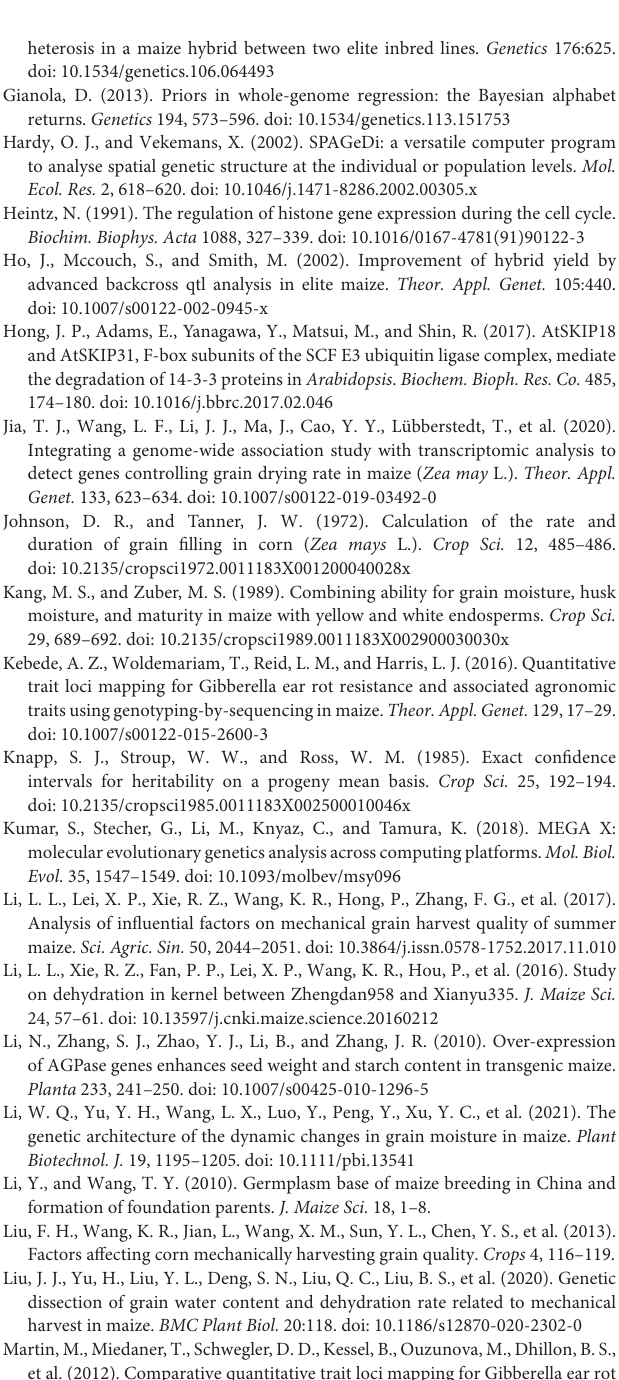
Supplementary Table 3 | The significant QTNs for KMC identified by MLM and six ML-GWAS models in this study. Supplementary Table 4 | Candidate genes around the 11 stable QTNs for KMC and their FPKM expression data in the whole kernle of B73 at different days after pollination